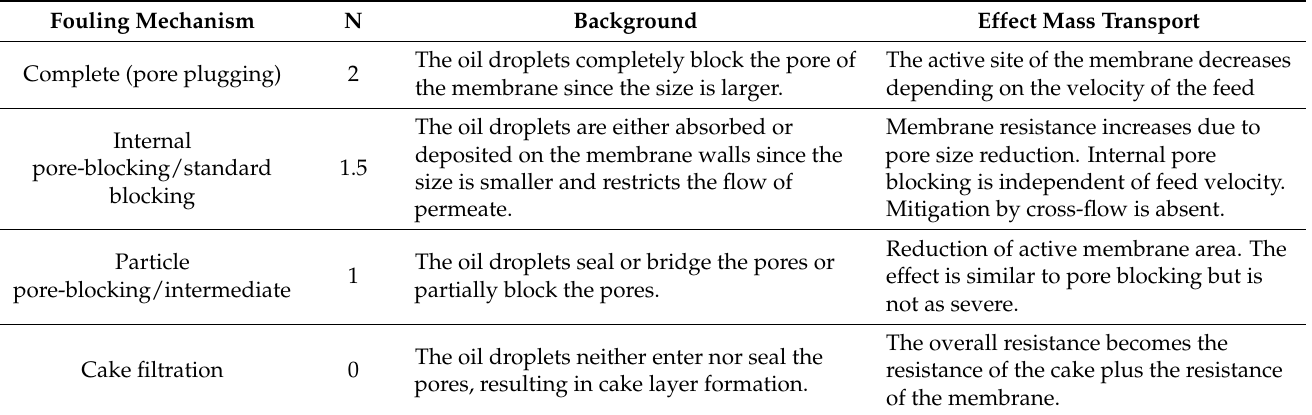
Table 2. Phenomenal background and effect of mass transport of fouling mechanism during cross- flow filtration [55].